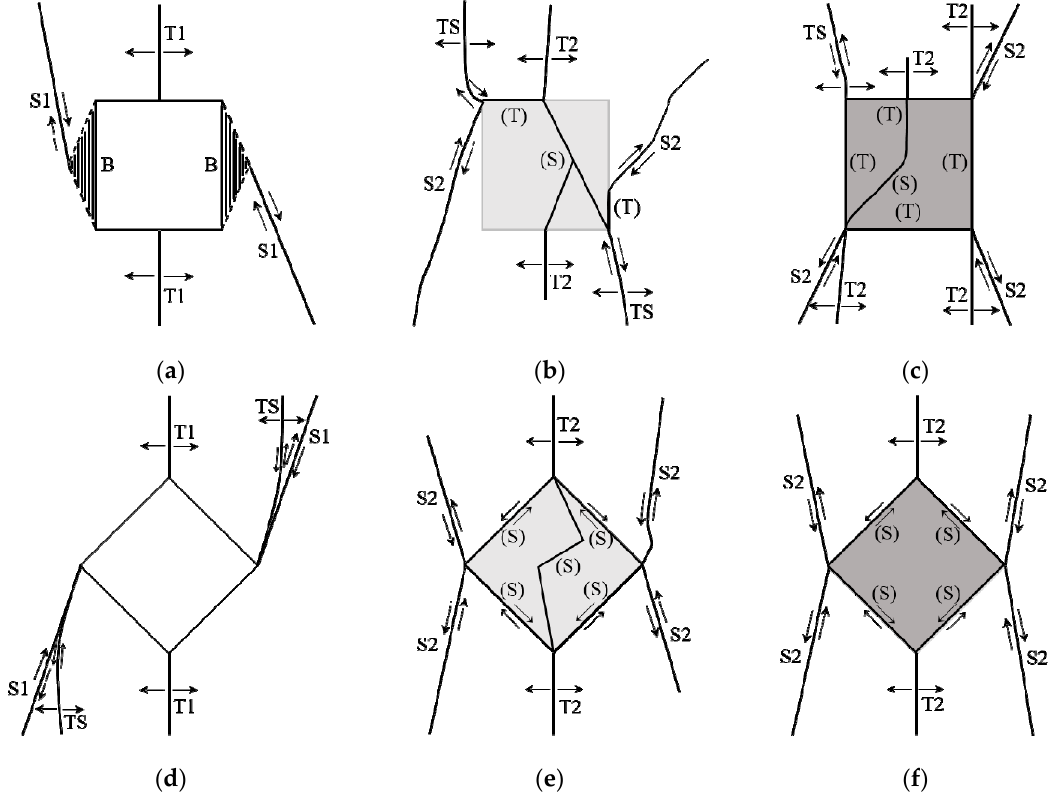
Figure 13. Crack patterns around a square hole under different filling modes and hole inclination angles: ( a ) Sq-0-A; ( b ) Sq-0-B; ( c ) Sq-0-C; ( d ) Sq-45-A; ( e ) Sq-45-B; and ( f ) Sq-45-C.